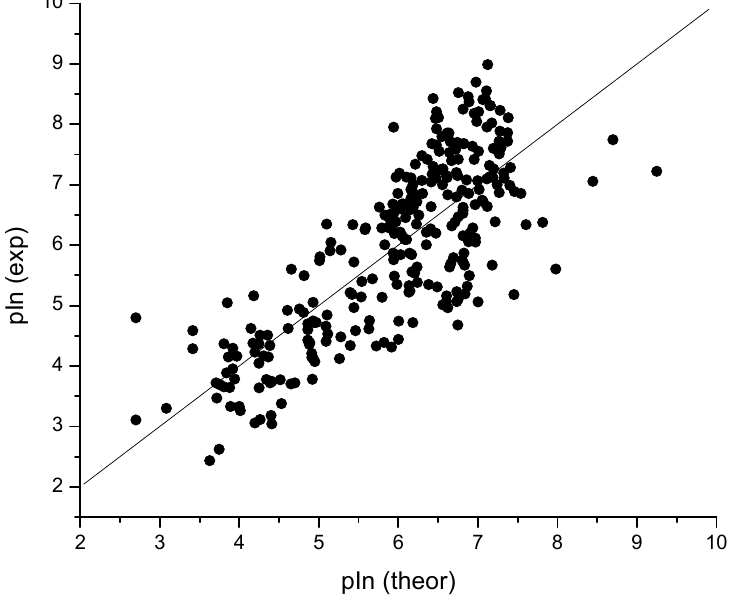
Figure 2. Plot of experimental vs. calculated (Model 6, Table 1) pIn values; r = 0.787, S.E. = 0.89 and S.E. cv = 0.90 ( N = 289).